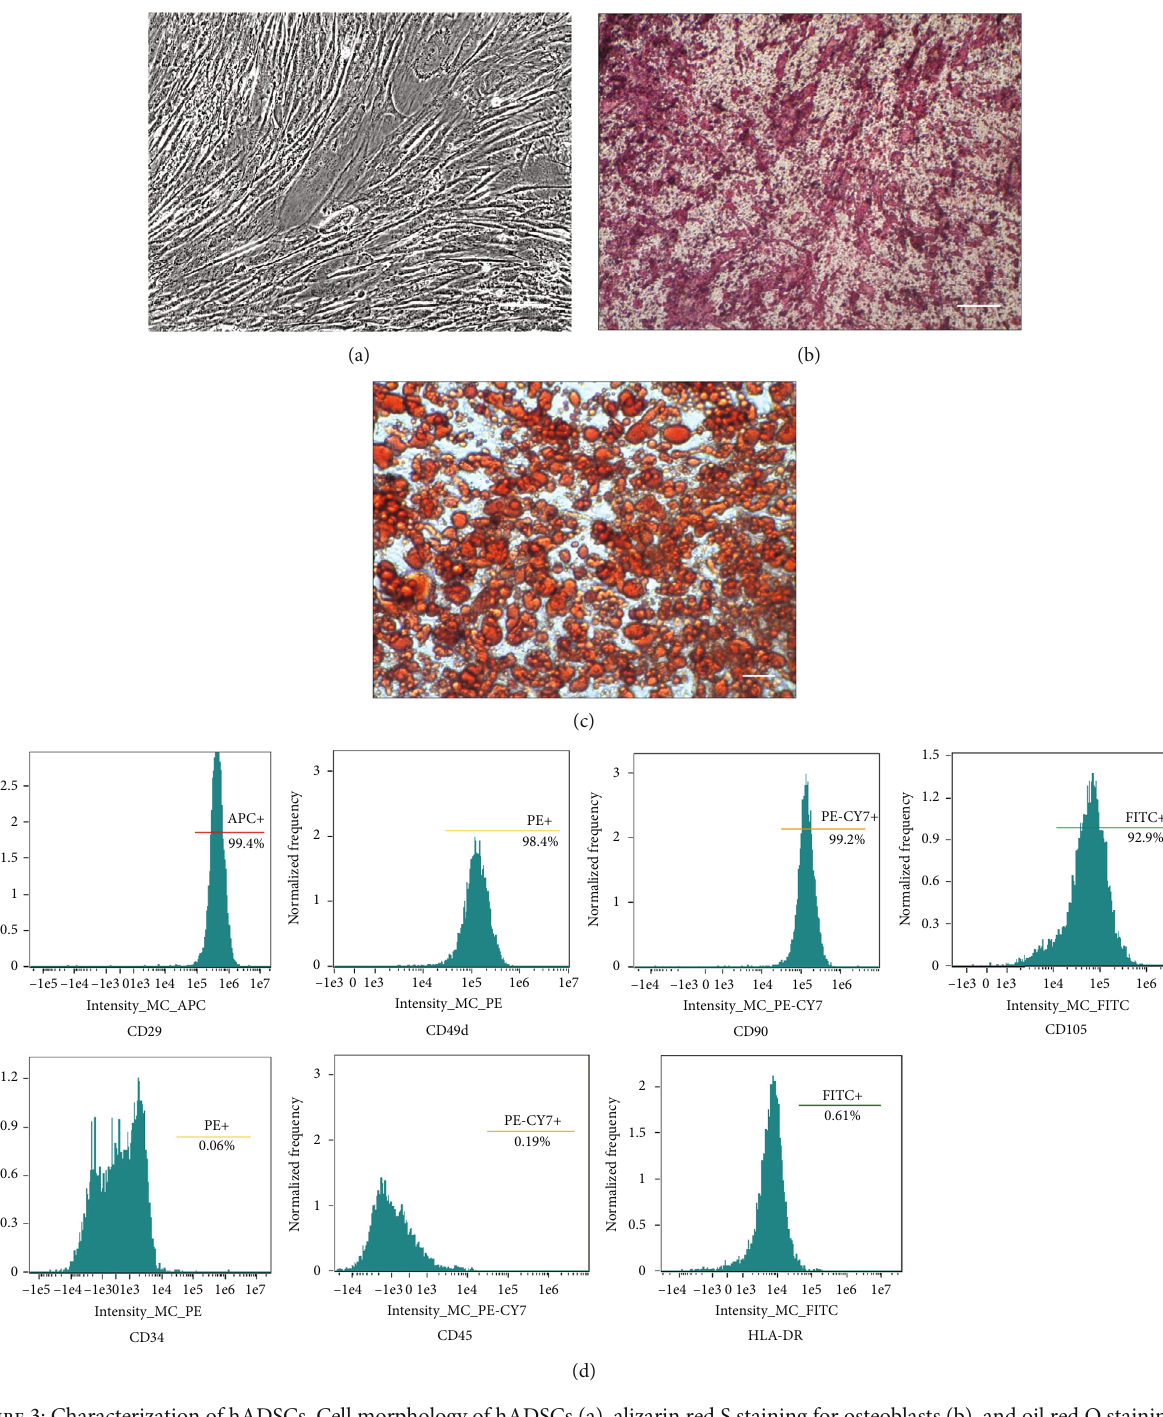
Figure 3: Characterization of hADSCs. Cell morphology of hADSCs (a), alizarin red S staining for osteoblasts (b), and oil red O staining for adipocytes (c). Scale bar indicates 100 μ m. Flow cytometry results showed that cells were strongly positive for CD29, CD105, CD90, and CD49d but negative for CD34 and CD45